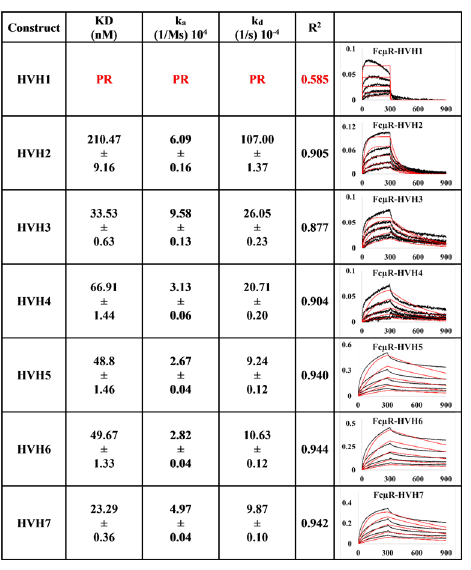
Figure 1. BLI measurement of pertuzumab IgM variants (PVH1-7) interacting with FcµR bound to AHC biosensor. KD, k and fitting curves are shown. PR indicates poor responses where the measurements have a poor R 2 value are shown in red. The x-axis and y-axis of the graph represent time (s) and response (nM), respectively. All values are rounded off to 2 decimal places. Triplicate experiments were performed, and standard errors were reported. PR: poor